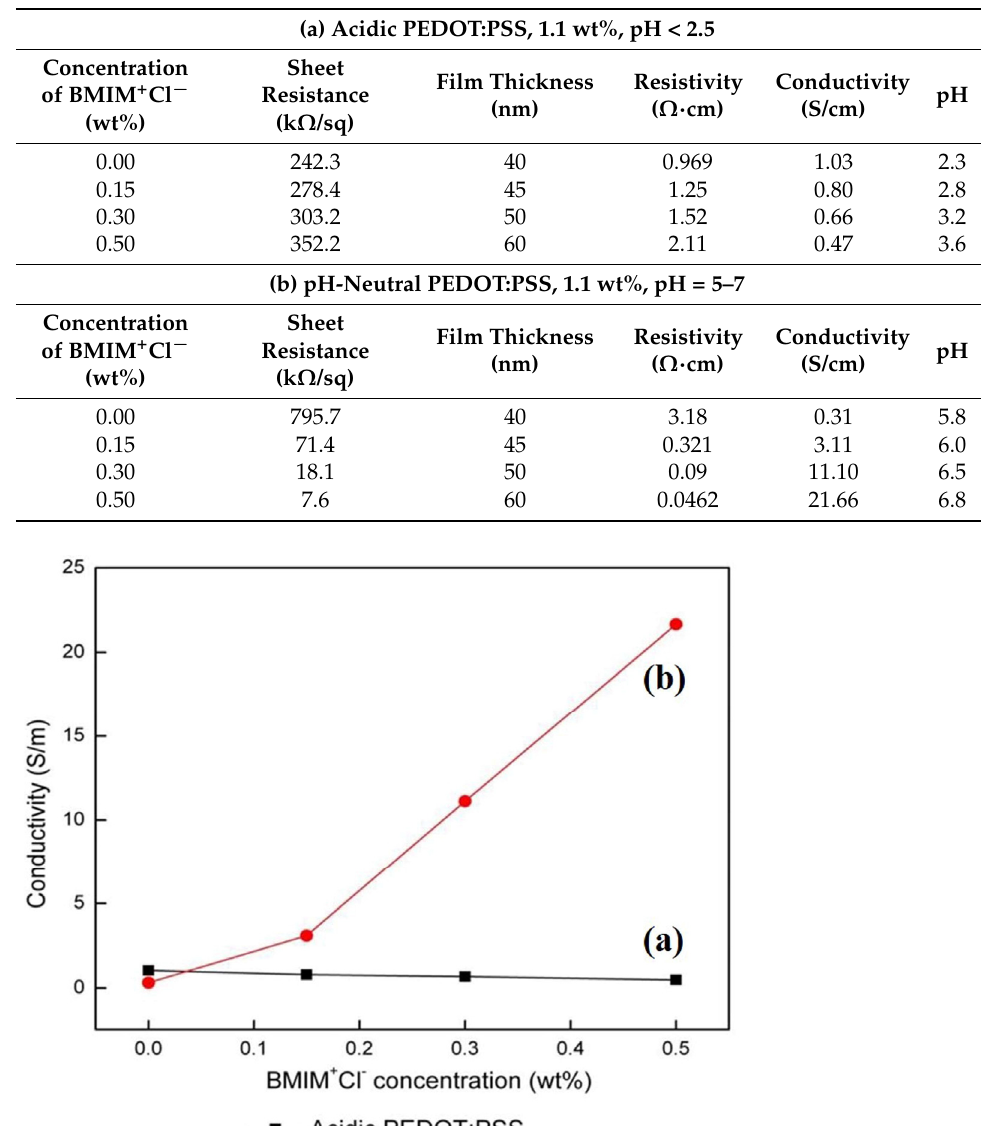
Table 1. Sheet resistance, film thickness, and conductivity of BMIM + Cl − -doped (a) acidic PEDOT:PSS